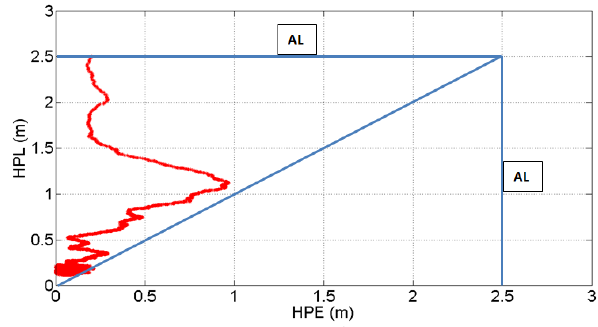
Figure 6. HPE and HPL correlation for in port navigation phase (after the convergence of the real-time IGS-RTS PPP-based GPS solution to the favorable performance – after 125 seconds).